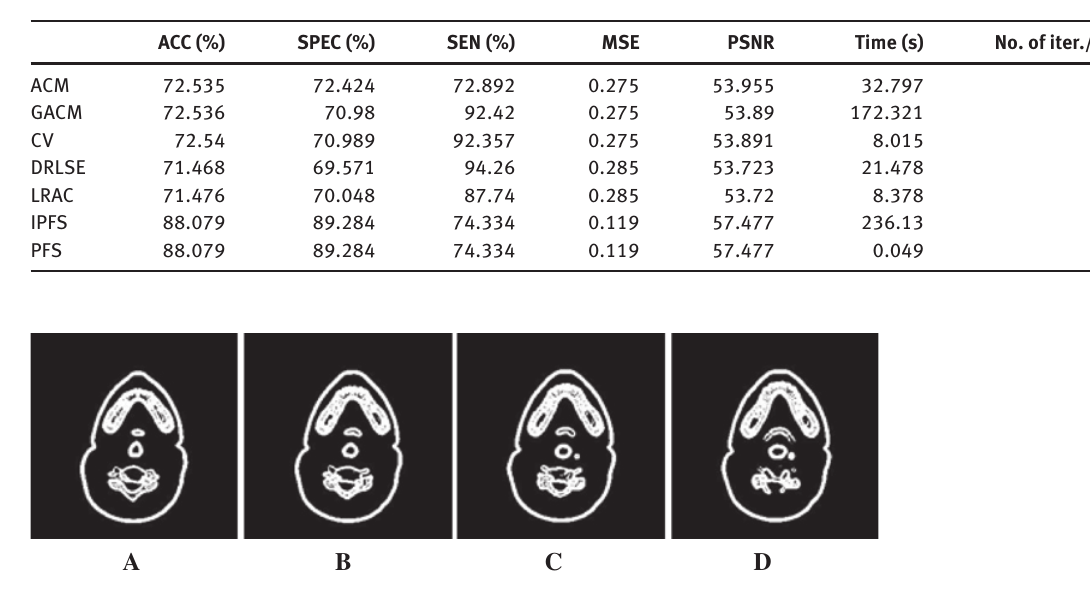
Table 2: Average performance analysis of different segmentation algorithms for 25 head CT slices.